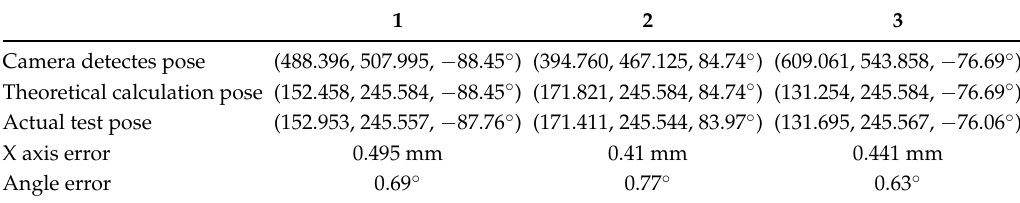
Table 4. Pose detection